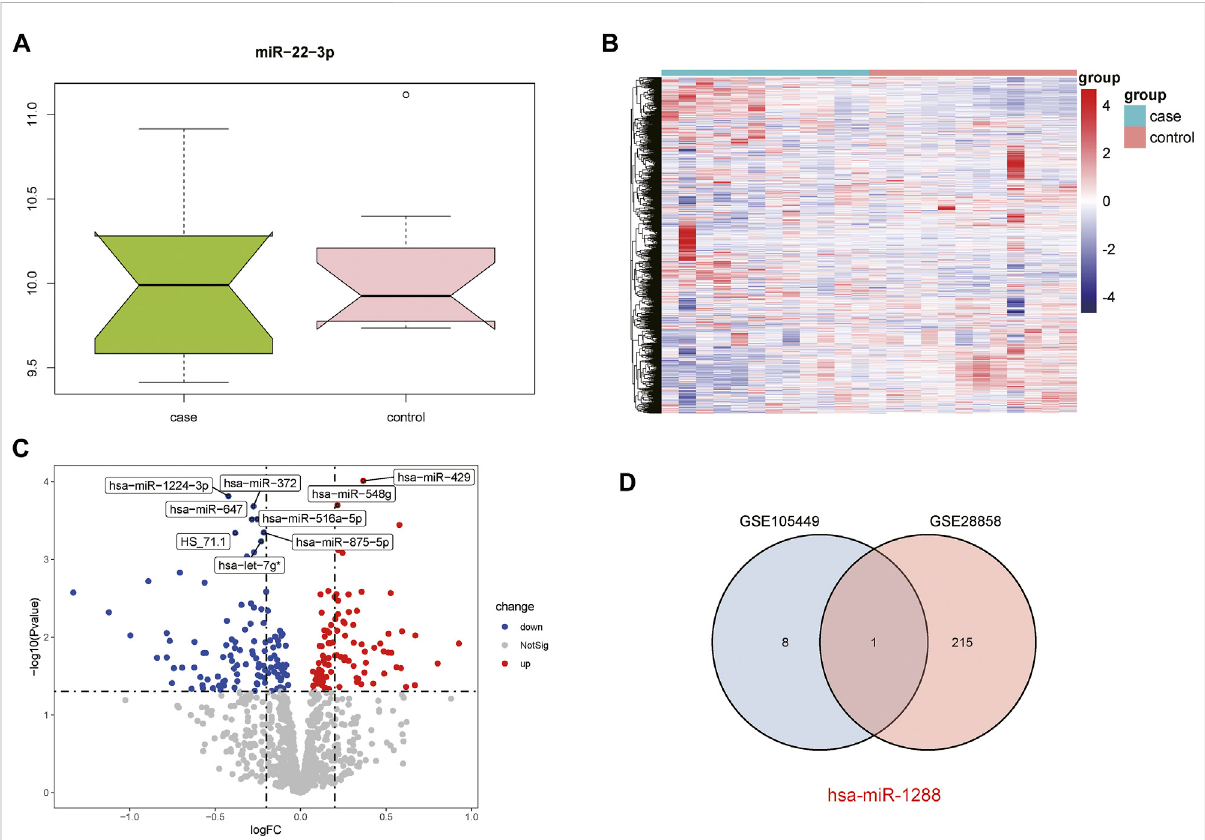
FIGURE 2 Acquisition of DEGs from the GSE28858 dataset. (A) Boxplot showing miR-22-3p expression. (B) Heatmap showing the mRNA expression pro fi lesofcasesamples,control1andcontrol2. (C) DEGvolcanomap.Red,green,andgrayrepresentupregulateddifferentialgenes,downregulated differential genes, and no differential genes, respectively. (D) Venn diagram of overlapping DEGs from the intersection of two independent datasets GSE105449 and